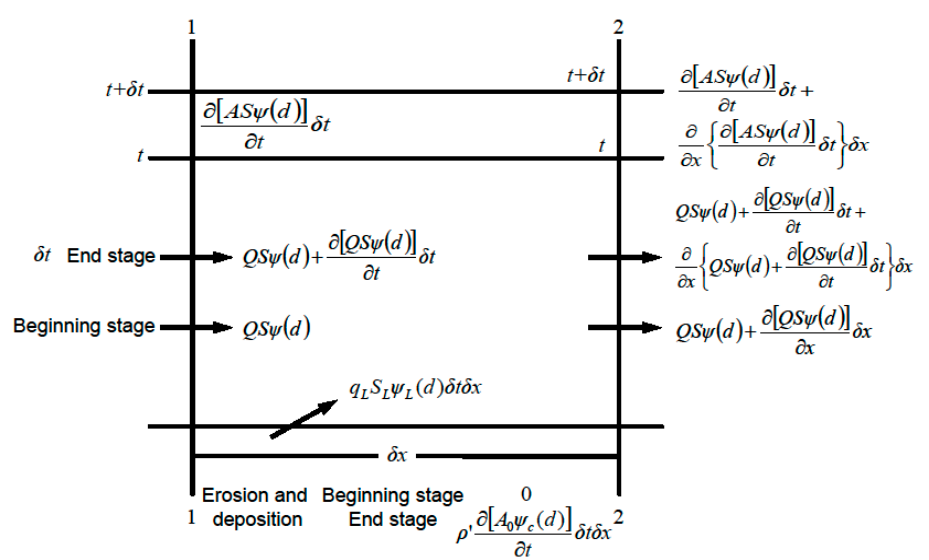
Figure A1. Schematic diagram of 1D suspended sediment and bed material Figure A1 . Schematic diagram of 1D suspended sediment and bed material exchange.